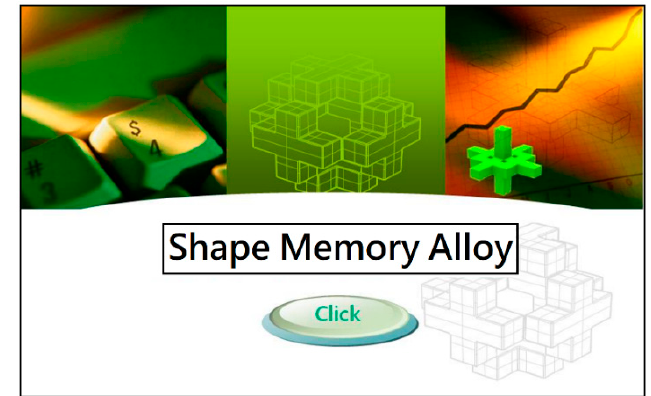
Figure 10. Initial screen of the SMA teaching module.